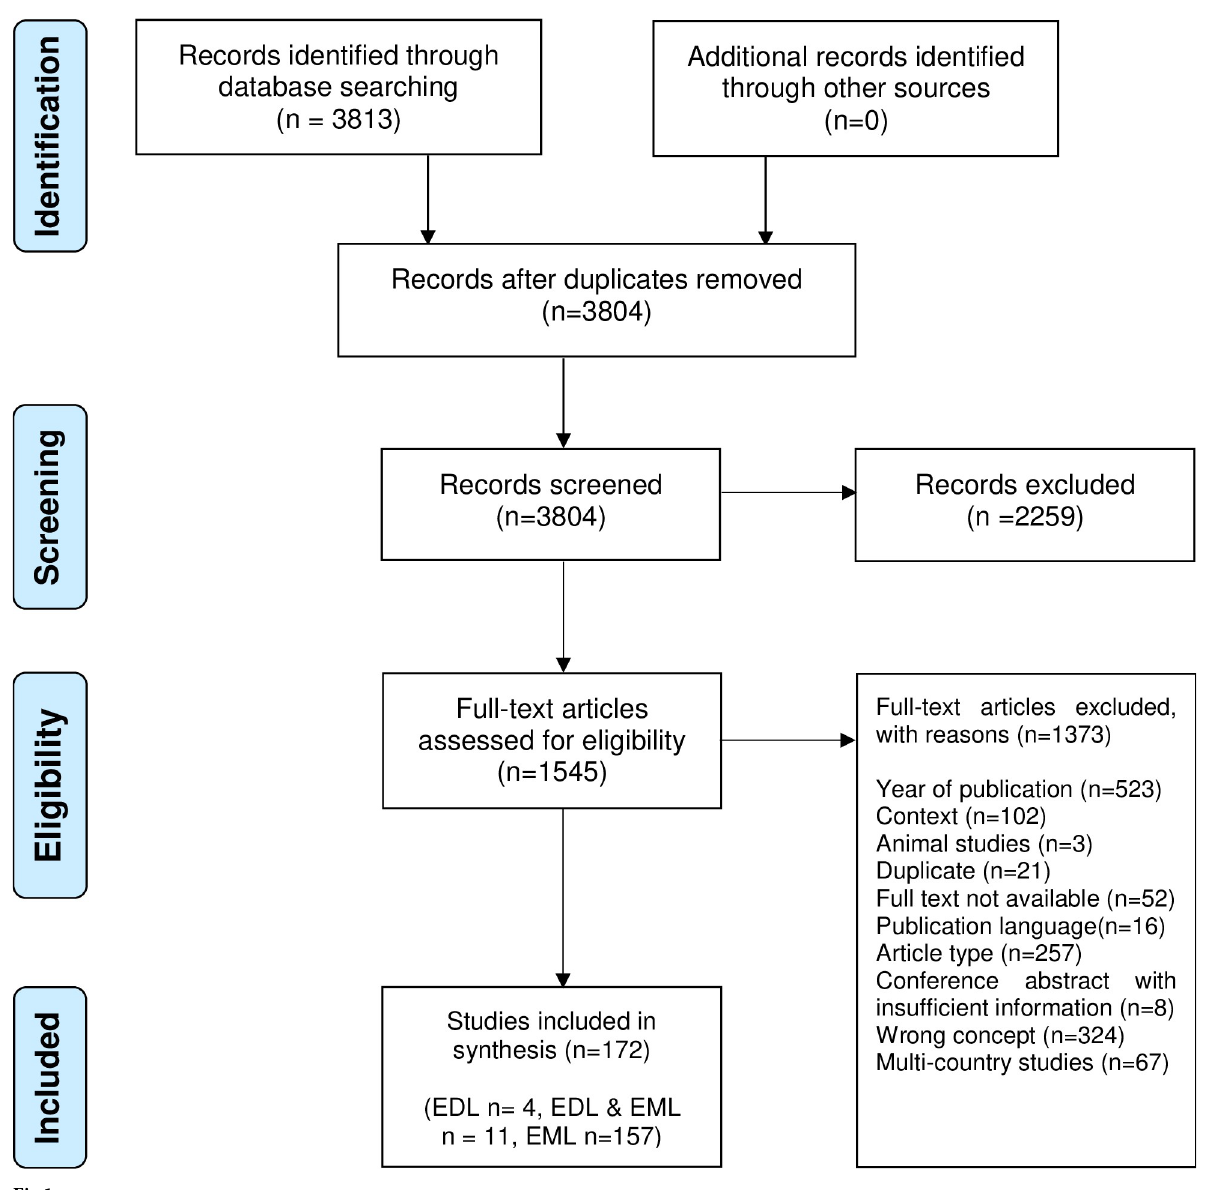
We included 172 studies. Four (2.3%) of the studies were on the implementation of EDL, eleven (6.4%) focused both on EDL and EML, and 157 (91.3%) focused only on the EML. A summary of key findings for all included studies can be found in the appendix (S3 Appendix). Of the (EDL) studies (n = 15), eight (53.3%) were from Eastern Africa, five (33.3%) from Southern Africa, and two (13.3%) from West Africa. Methodologically, twelve (80%) of EDL studies used quantitative methods (cross-sectional designs), and three (20%) used the mixed methods approach (Table